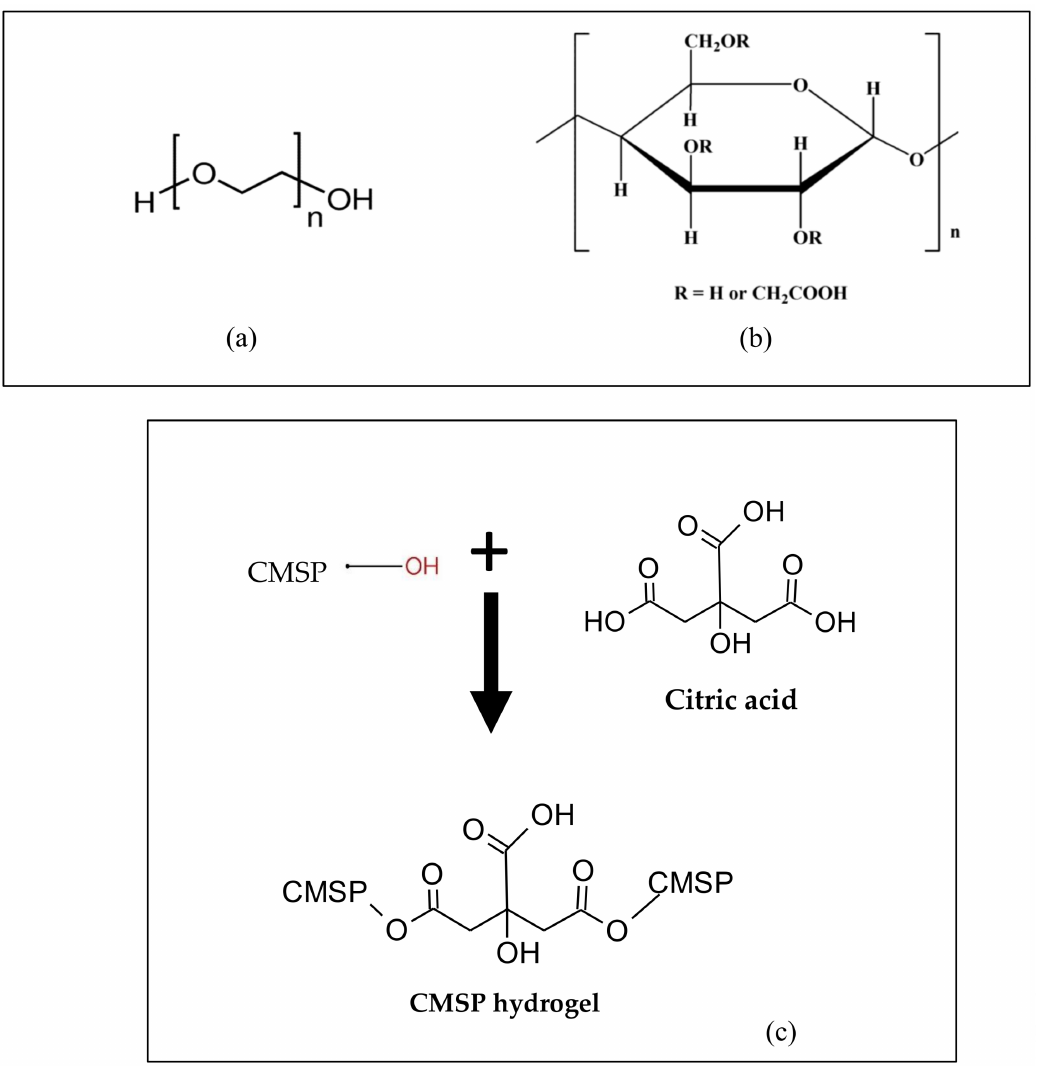
Figure 6. ( a ) PEO structure ( b ) CMSP structure ( c ) Proposed mechanism of cross-linking reaction between cellulose (CMSP) and citric